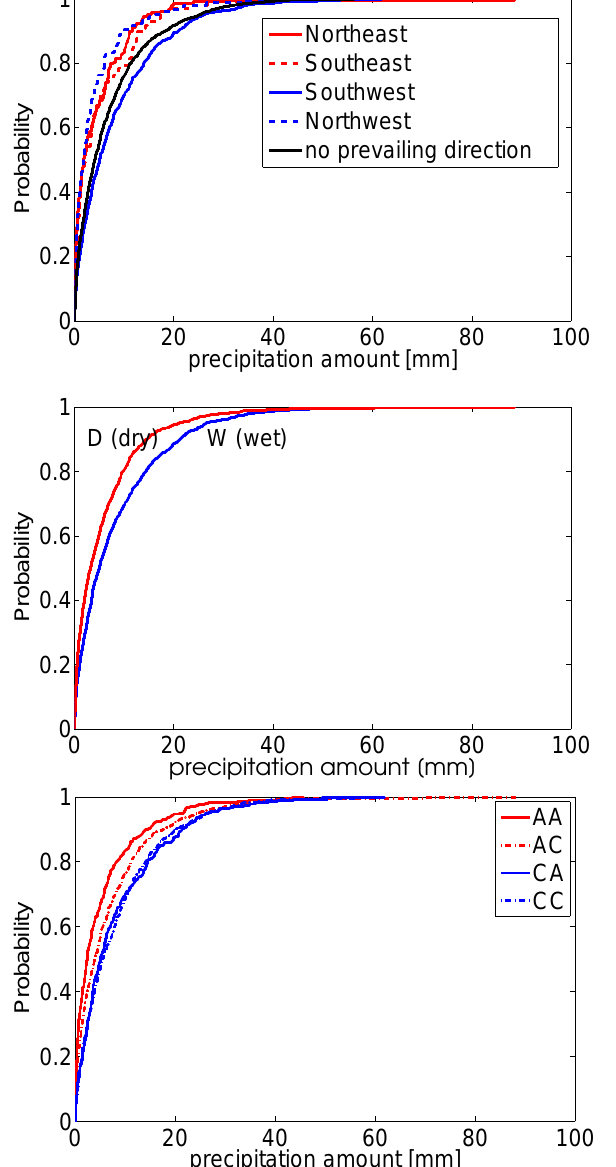
Fig. 12. Empirical CDF of observed precipitation in Garmisch-